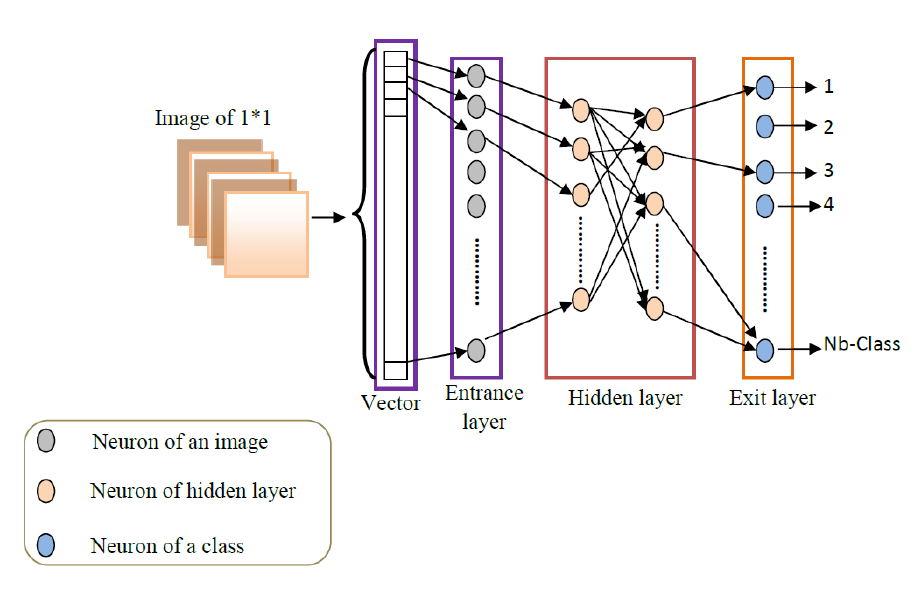
Figure 7. Classification phase by